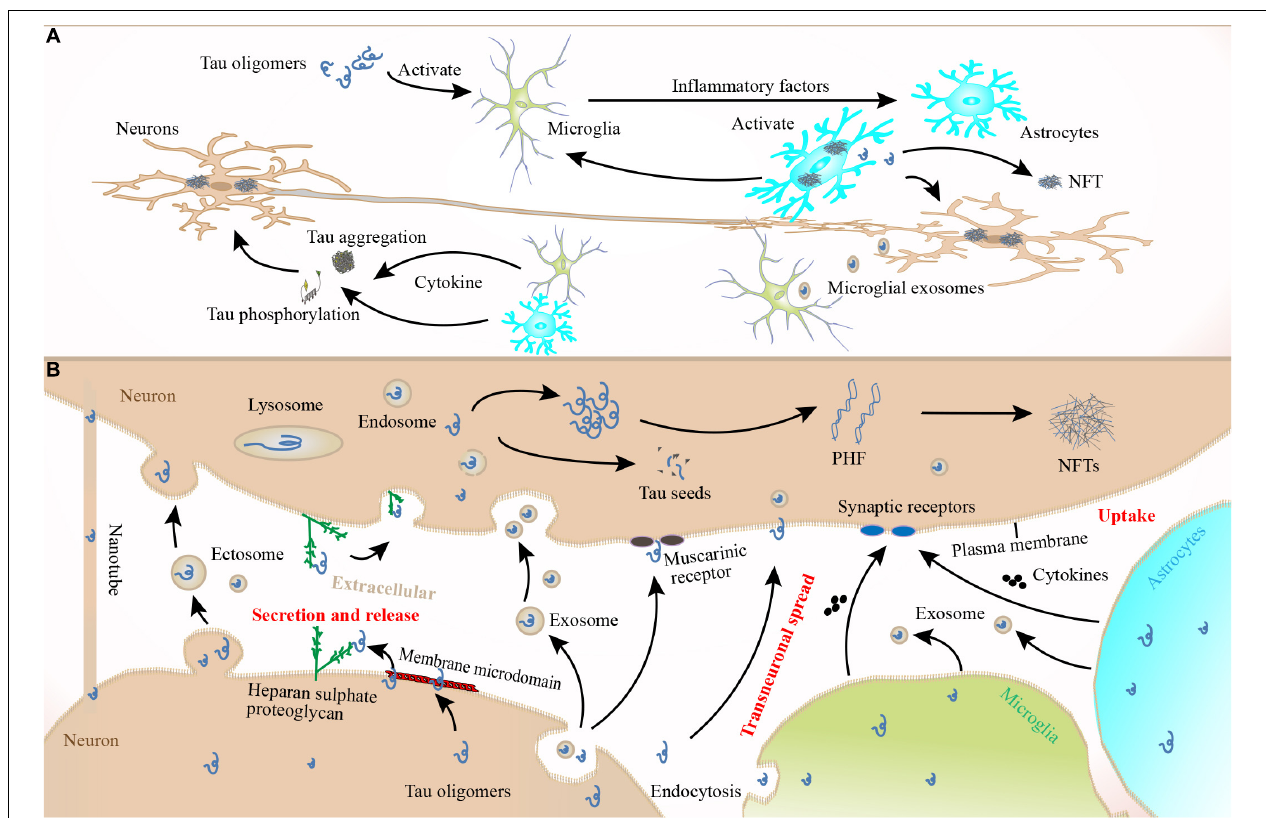
FIGURE 4 | Tau pathology spread. Once released into the extracellular space, tau can be transported to connected cells via exosomes or ectosomes. Tau can also be transported to other cells by binding to muscarinic (M1, M3) receptors or synaptic receptors or via special structures such as membrane microdomains and HSPGs. There may also be nanotubes between cells, which can also spread tau oligomers. The plasma membrane may play a role in tau transmission through endocytosis-mediated uptake of tau oligomers. Microglia can also phagocytose secreted tau oligomers that are then spread to healthy neurons in exosomes, and astrocytes may be involved in this process. Both microglia and astrocytes can secrete cytokines that act on connected neurons, which further accelerates tau pathology. However, the specific mechanisms underlying the roles of microglia and astrocytes in tau pathology spread remain unclear. When tau oligomers or monomers are released by lysosome or ingested by recipient cells, they will misfold and form toxic seeds, PHFs, or NFTs. Once the recipient cells spread the pathological tau fragments to other cells, this perpetuates a vicious cycle that exacerbates